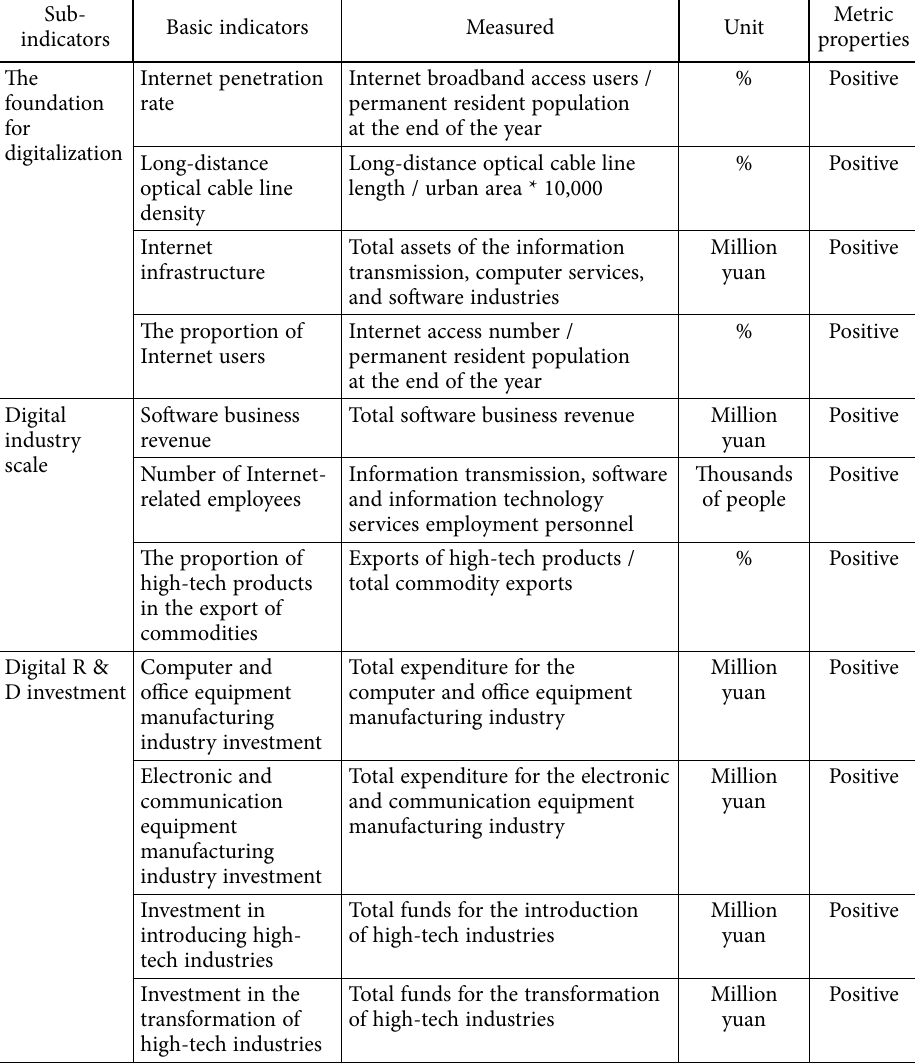
Table 1. Digital economic index